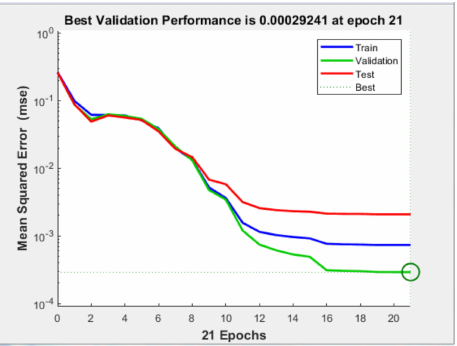
Figure 2. Changes in the MSE calculated for the following sets: test, training and validation.